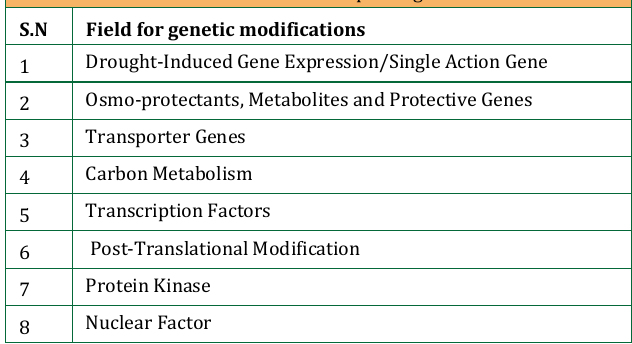
Table 2: Modification field for improving wheat resistance